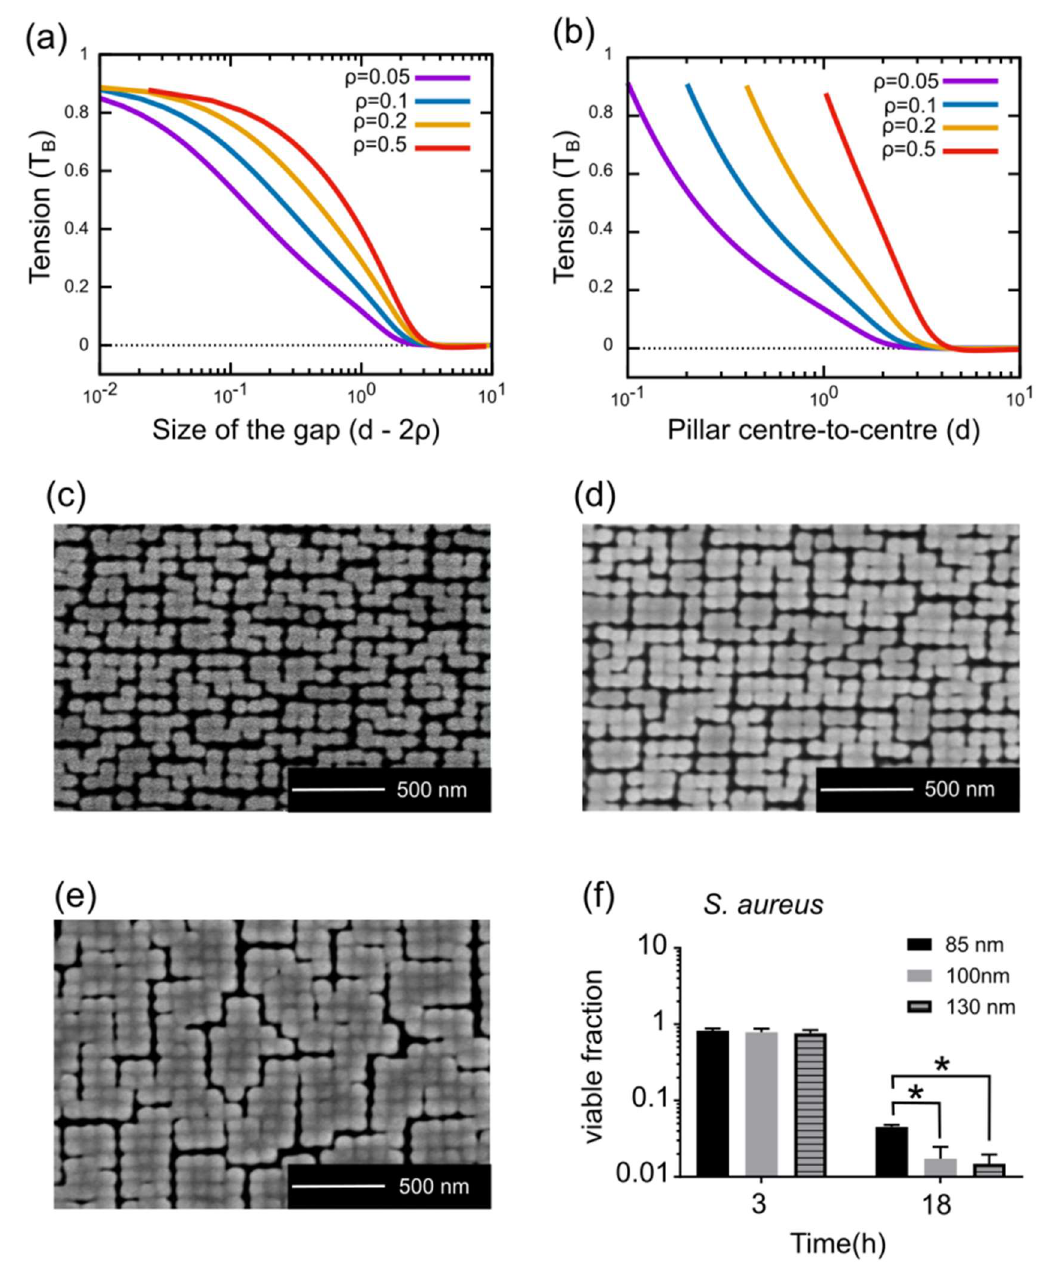
Figure 6. The effects of pillar cap size on bactericidal activity. ( a–b ) shows the dependency of tension in the suspended region on the size of the gap between ( a ) pillar caps and ( b ) the center-to-center pillar distance. Different lines correspond to various radii of the pillars. ( c–e ) shows SEM top-views of surfaces made by different durations of gold sputtering on 260 nm tall silicon nanopillars. The duration is equivalent to sputtering a ( c ) 85, ( d ) 100, and ( e ) 130 nm thick coating on a flat surface. ( f ) shows the fraction of S. aureus cells suspended in water that survived 3 and 18 h of incubation on top of the cotton swab-shaped nanopillars with a gold cap shown in A, B, and C. * indicates P-value < 0.005, measured by an unpaired, two-tailed parametric t-test.